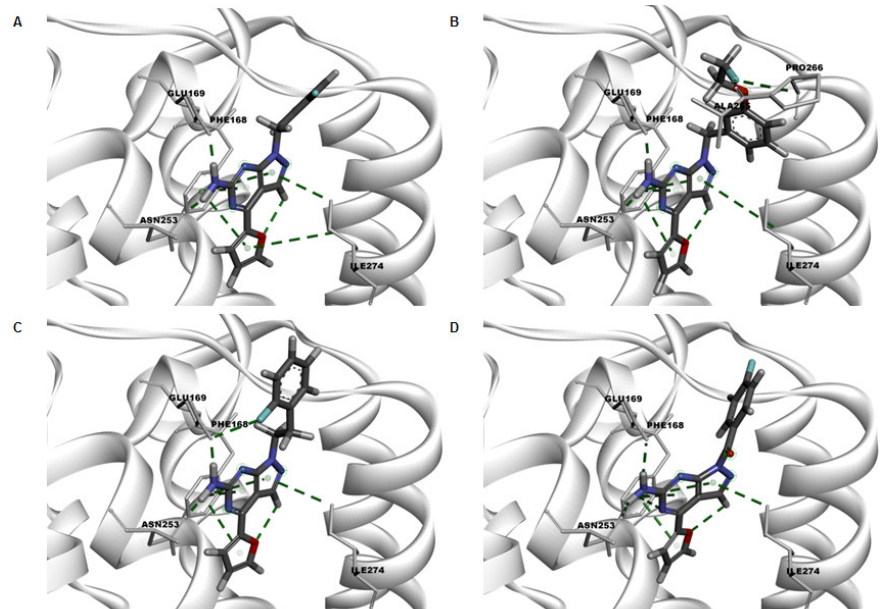
Figure 4. Key interactions in green dotted lines of the docking poses of representative active com- pounds ( A ) PPY2 , ( B ) PPY17 , ( C ) PPY19 and ( D ) PPY21 in the binding site of crystal structure of A 2A R (PDB ID: 4EIY).